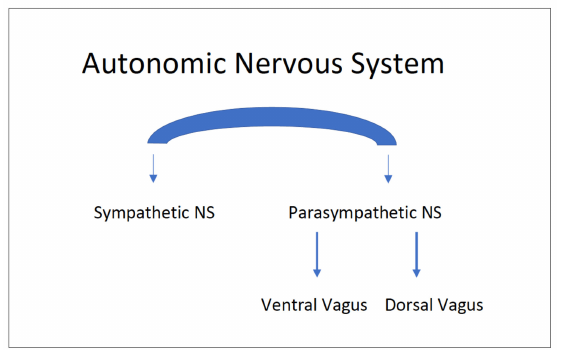
Figure 3. Autonomic Nervous System pathways (Adapted with permission from D. Dana